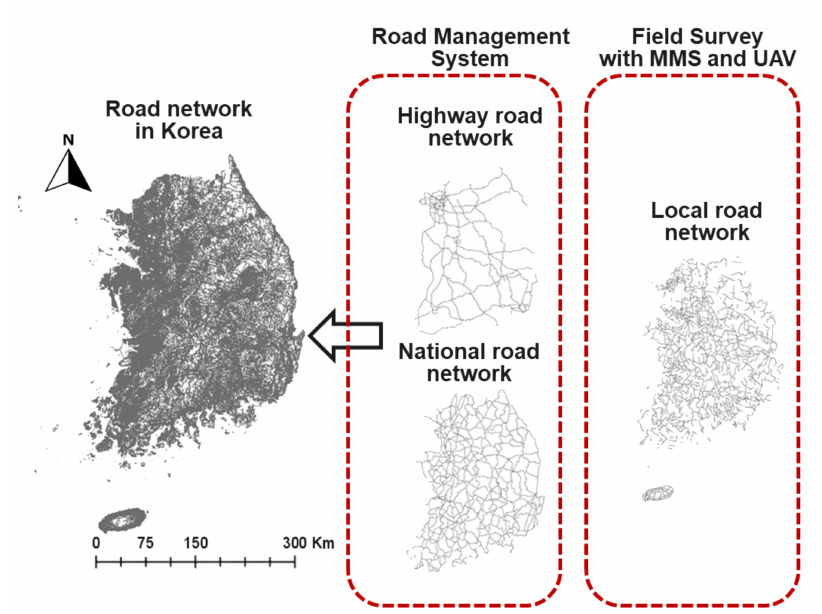
Figure 5. The full road network data of Korea obtained from Road Management System (RMS) and field surveys.